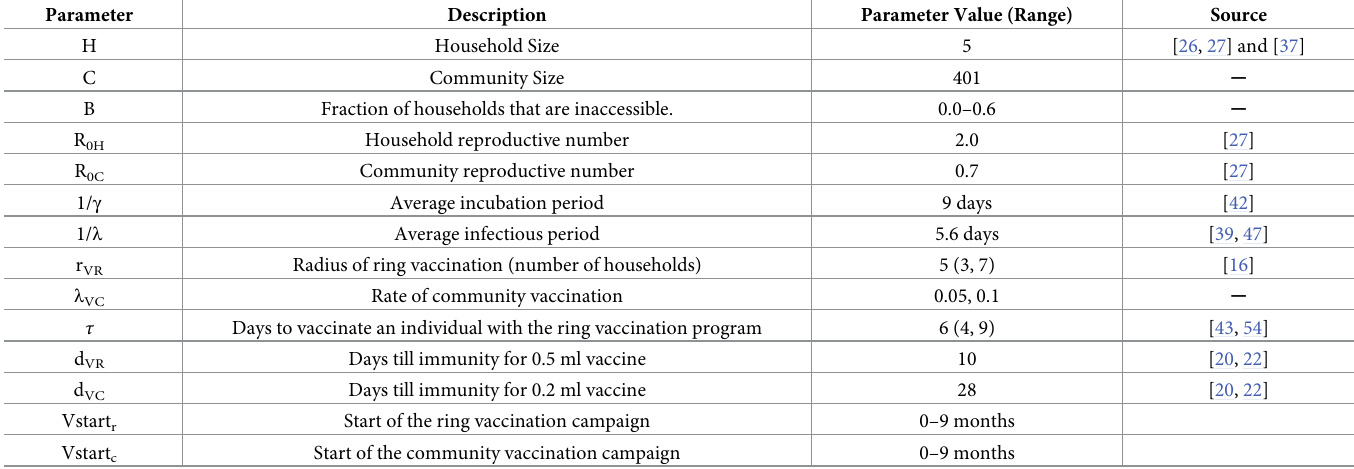
Table 1. Parameter values used in simulations. Description of each model parameter, the value or range that is used, and the reference source for the value that is used if applicable. Parameter Description Parameter Value (Range) Household Size Community